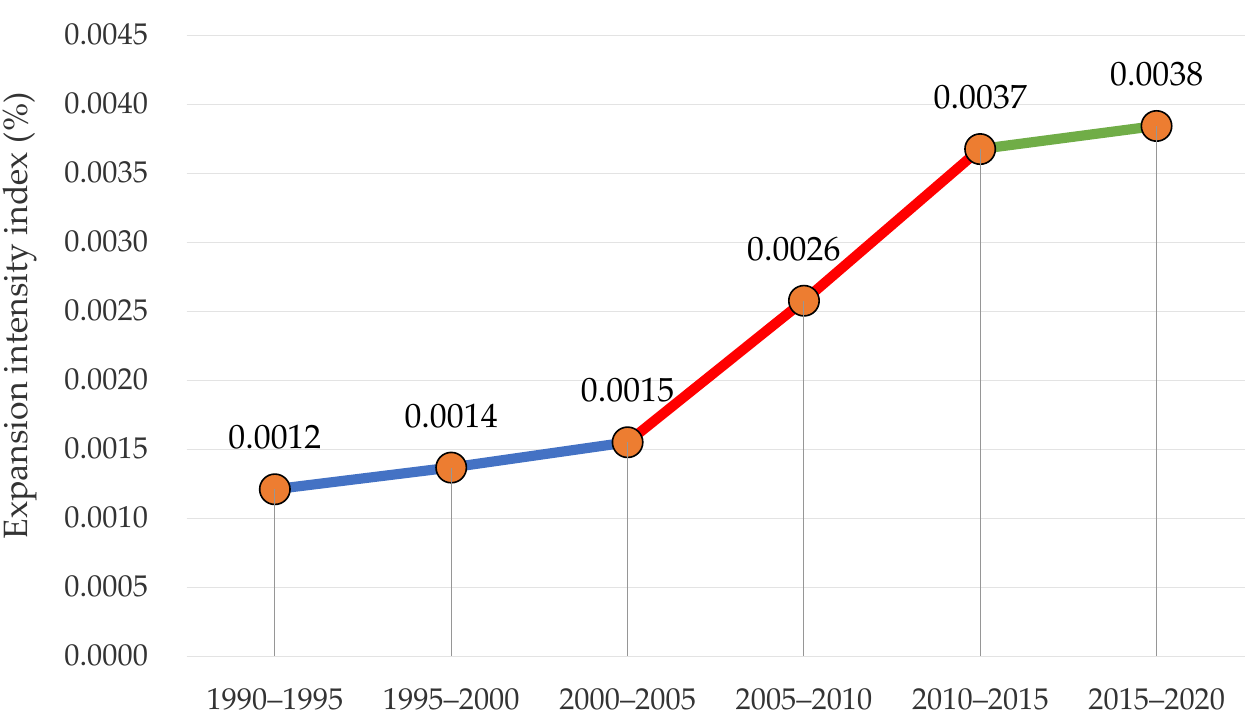
Figure 2. Expansion intensity Central Plains urban agglomeration in different periods.